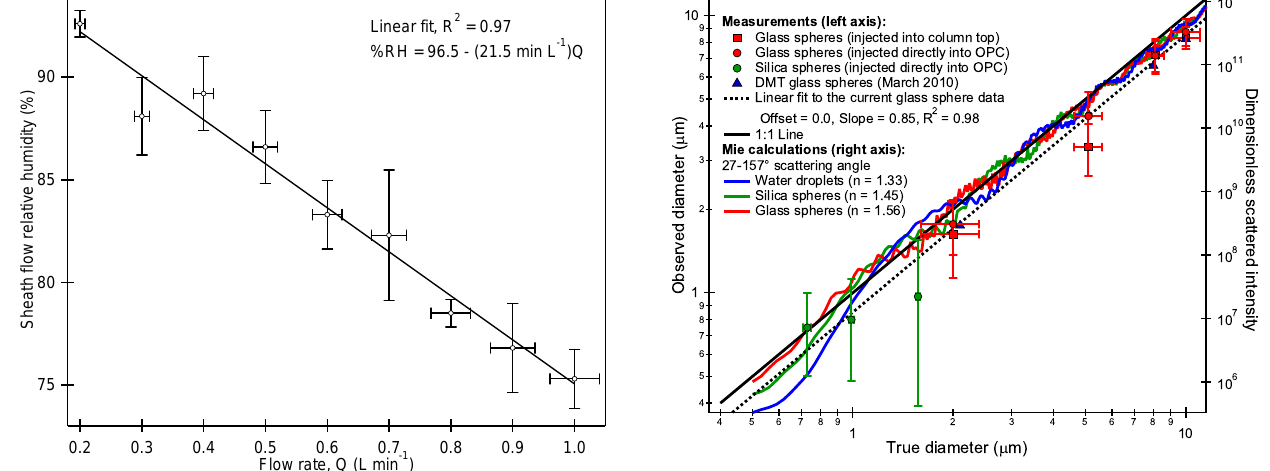
Fig. 3. Example of measured sheath flow relative humidity as a function of flow rate. The RH error bars represent variability from at least four measurements and the flow rate error bars show the average uncertainty (4%).